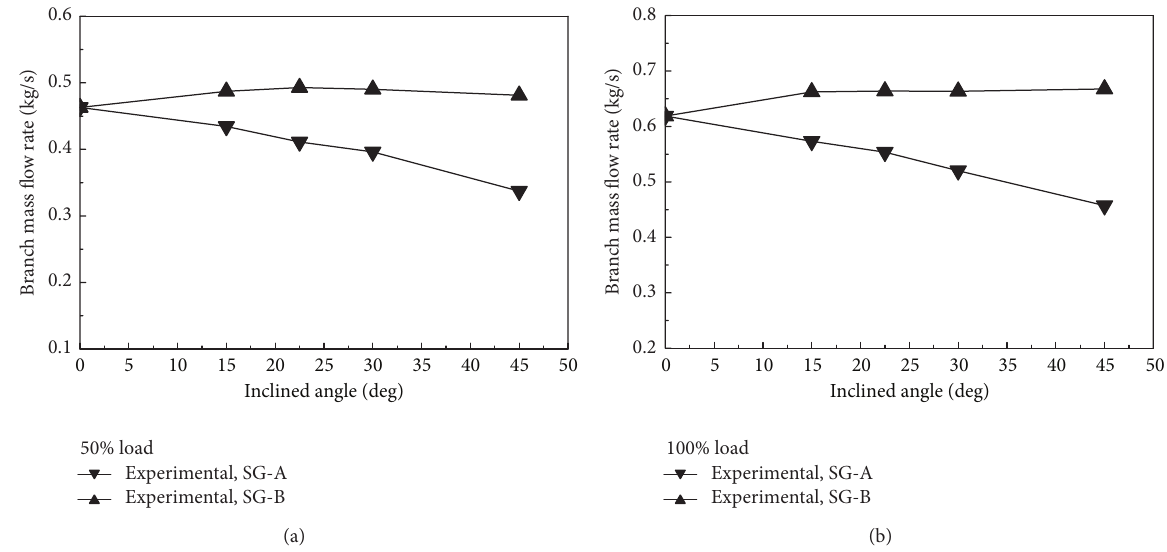
Figure 4: Branch flow rates under different inclined angles—(a) 50% load; (b) 100% load.